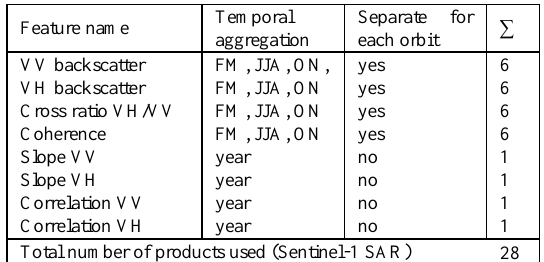
Table 3 . Annual and seasonal S-1 time series products (SAR) used as predictor variables. FM, JJA, ON refer to the time span aggregation February-March, June-July- August and October-November. Slope and Correlation refer to the backscatter-incidence angles. Table adapted from Bruggisser, et al.